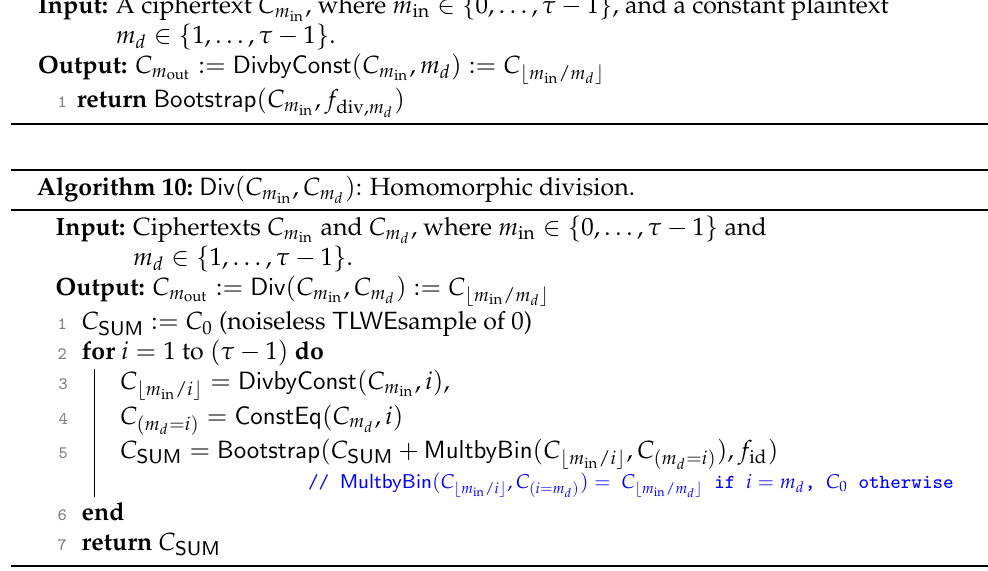
Algorithm 9: DivbyConst ( C m